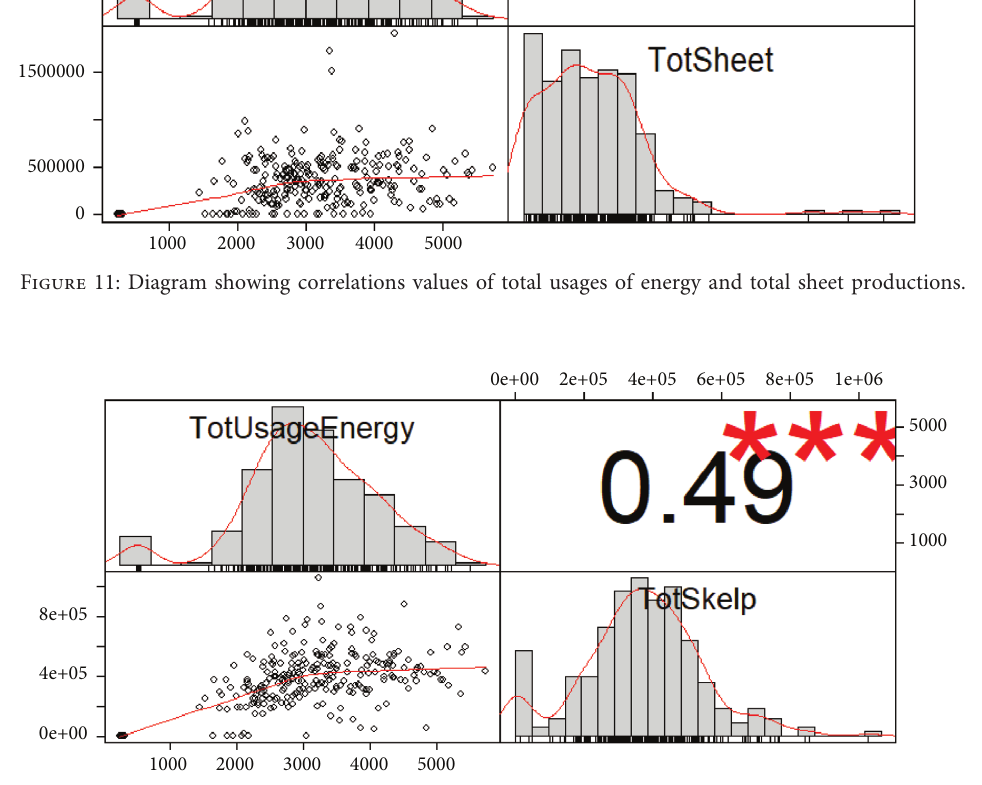
Figure 12: Diagram showing correlations values of total usages of energy and total Skelp productions.